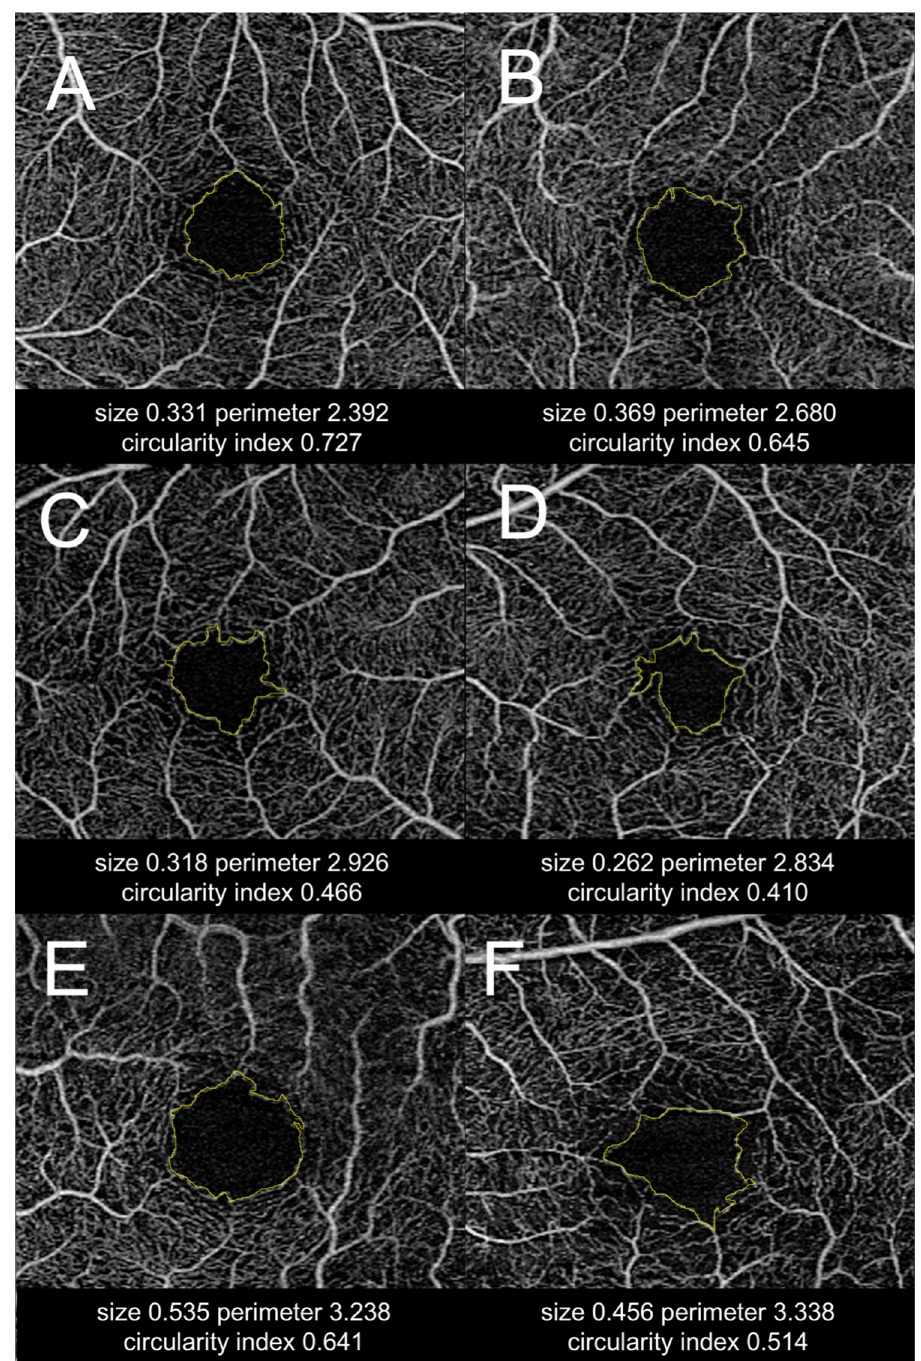
Fig 2. Representative cases with different foveal avascular zone (FAZ) assessment. Two healthycases (A, B) and four glaucomacases (C, D, E, F). (A, B) Healthy eyes have a relatively smaller FAZ size and a highercircularity index. (C, D) Glaucoma patients with remarkable foveal capillarydropout, which is reflected in lower circularity index. (E, F) Advancedglaucomapatients with notablyenlargedFAZ size (E) or distorted FAZ shape